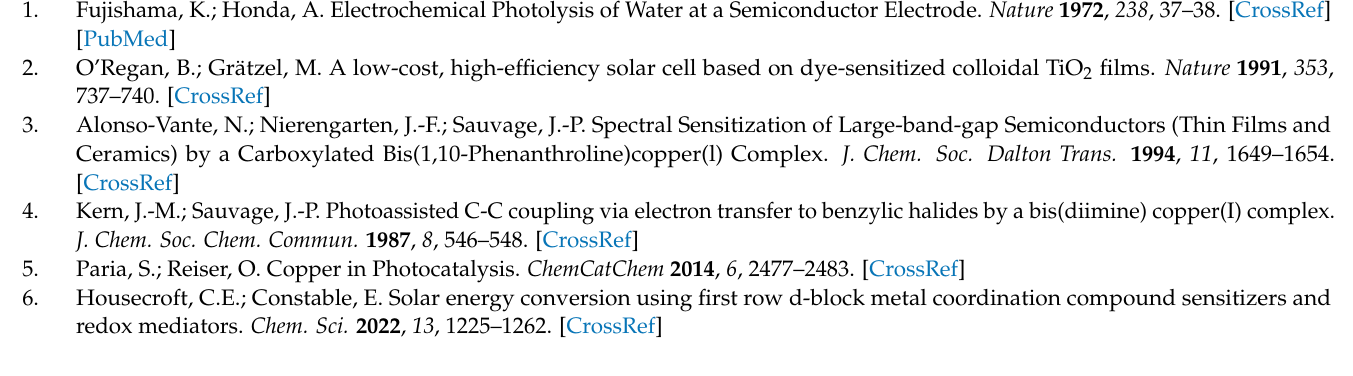
Figure S2: 1 H, 13 C and DEPT spectra of complex C2 , Figure S3: 1 H, 13 C and DEPT spectra of complex C3 , Figure S4: 1 H, 13 C and DEPT spectra of complex C4 , Figure S5: 1 H, 13 C and DEPT spectra of complex C5 , Figure S6: 1 H, 13 C and DEPT spectra of complex C6 , Figure S7: 1 H, 13 C and DEPT spectra of complex C7 , Figure S8: 1 H, 13 C and DEPT spectra of complex C8 . X-ray structure